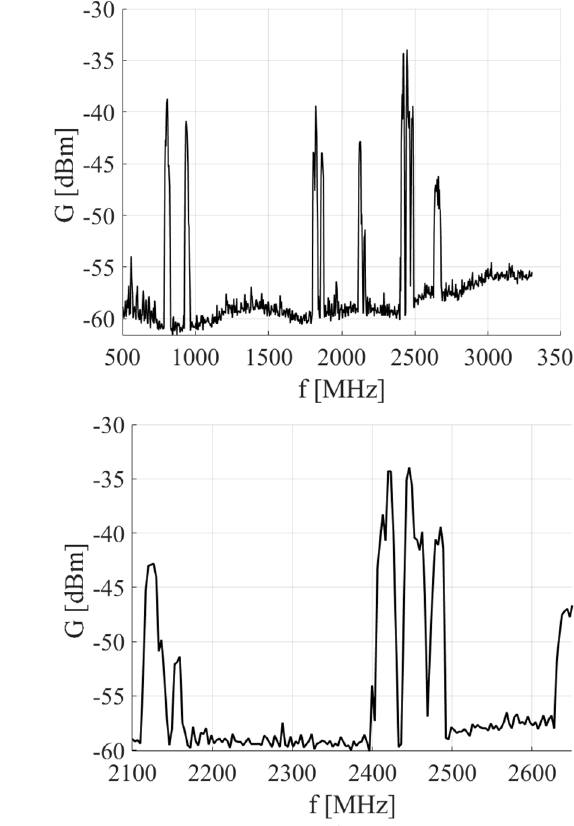
Figure 11. Experimental setup: measurement point (red cross) inside the car ( a ) CAR A, and ( b ) CAR B.